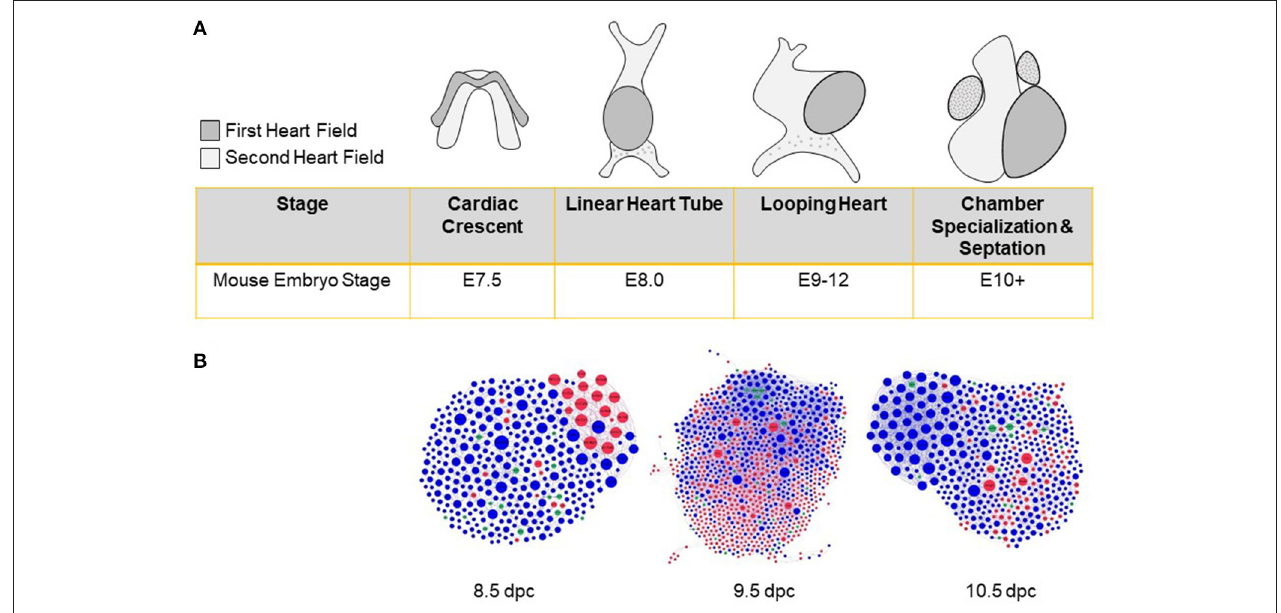
FIGURE 2 | Sex biases in heart development before gonad formation. (A) Cardiac progenitors from the first and second heart fields establish the cardiac crescent during late gastrulation. Subsequent proliferation and differentiation of cells lead to the formation of a linear heart tube and cranial positioning of the atria. Remodeling then leads to chamber formation, septation, and valve development. (B) Protein-protein interaction networks were constructed from differentially expressed genes as assayed in single-cell RNA-seq experiments (84) and sex-stratified by us (83) for 8.5, 9.5, and 10.5 days post-coitum (dpc) hearts. Networks include sex-biased modules highlighted by red (female-enriched) and blue (male-enriched) nodes. Examples of sex-biased genes for 8.5, 9.5, and 10.5, respectively, include: Ctc1, Tbx2, Trim25 (female-biased); Km2a, Dusp3, Ube2c